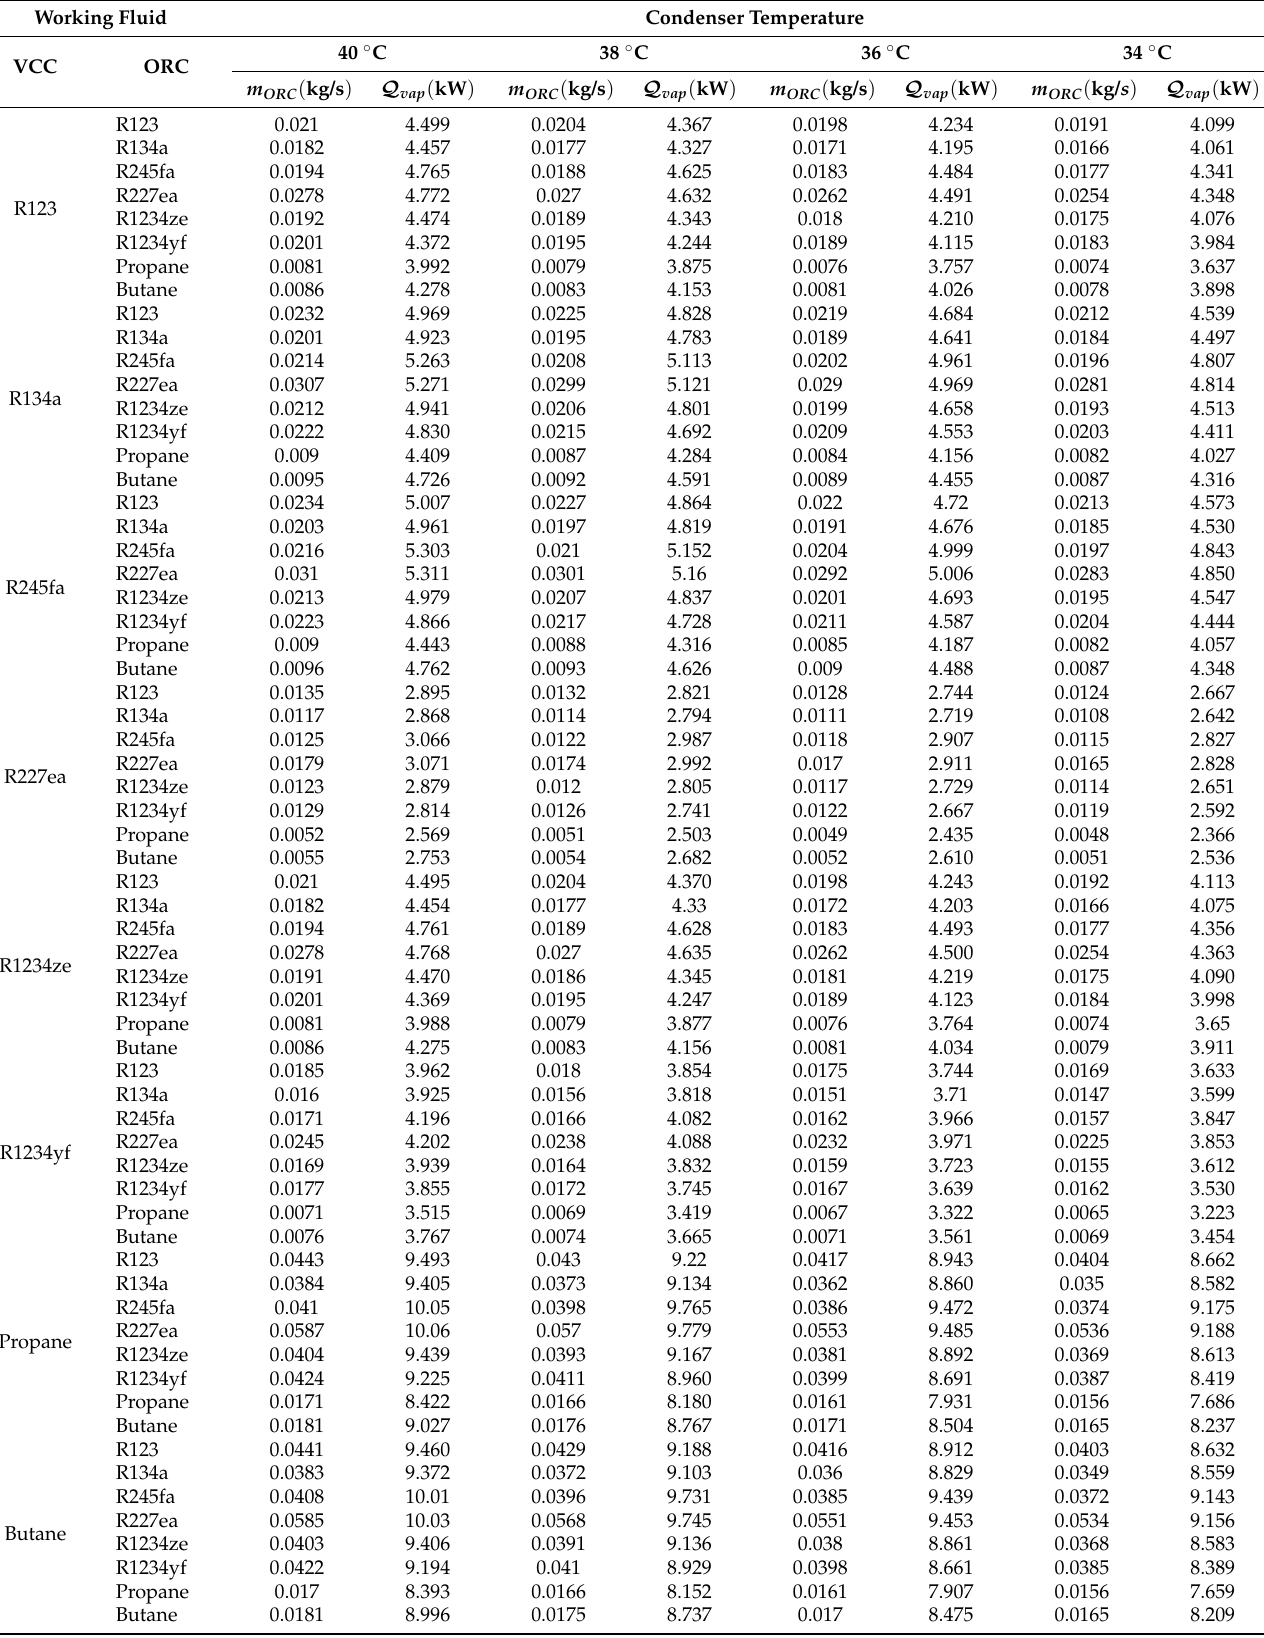
Table 2. Mass flow rate and heat input required for fixed condenser temperature with various combinations of working